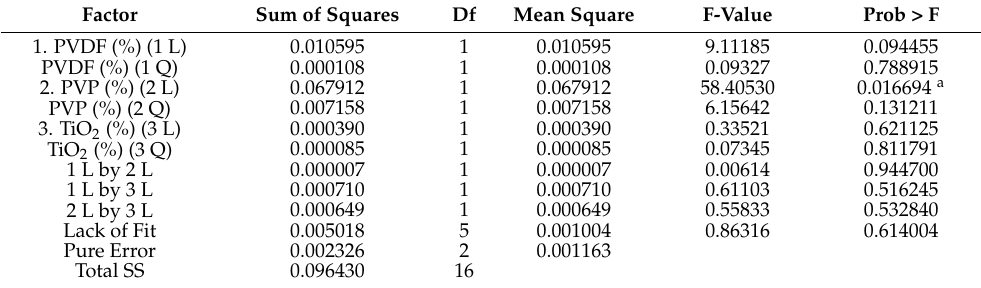
Table 7. Analysis of variance of the pore size ( µ m). R 2 = 0.92384; Pure error = 0.0011628. (L) is the linear relation, (Q) is the quadratic relation of the factors, and Df is the degrees of freedom of the